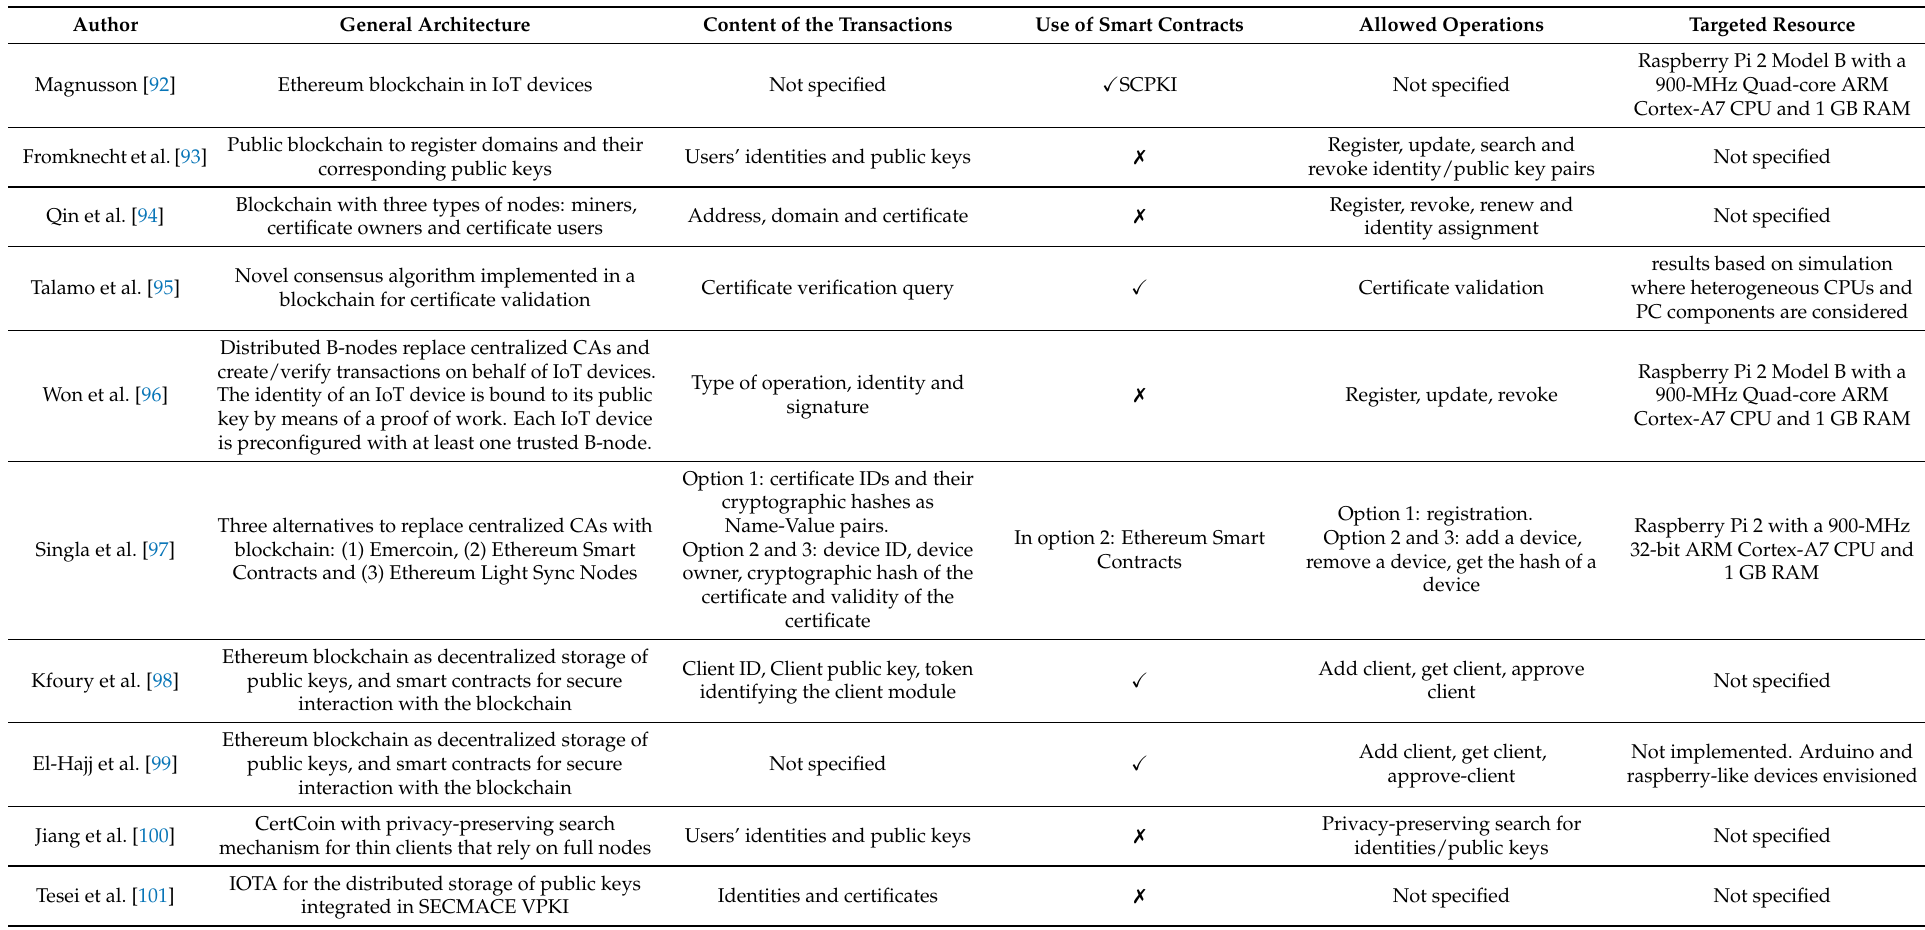
Table 5. Summary of approaches based on distributed